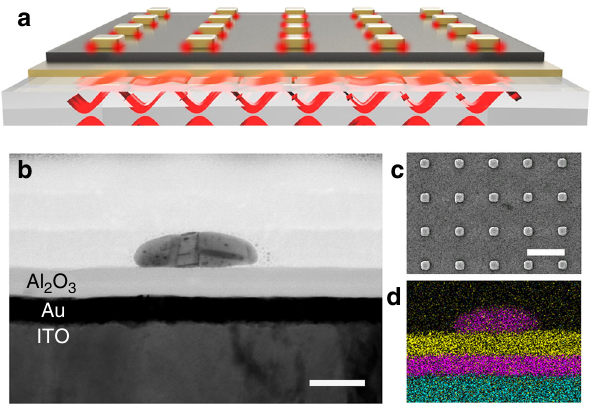
Fig. 1 Sample geometry. a Schematic diagram for the structure and the mode distribution. The localized surface plasmon resonance (LSPR) mode is located mainly at the interface between the nanoblocks and Al 2 O 3 layer. The surface plasmon polariton (SPP)-Bloch wave is con fi ned mainly on the lower surface of the Au fi lm. b Sectional view of the sample imaged by scanning transmission electron microscope (STEM) (scale bar: 50 nm).